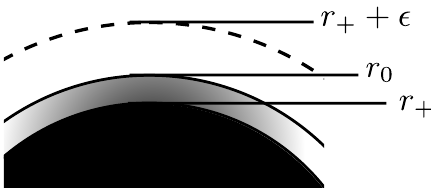
Figure 1. The boundary condition is imposed at a radius r + + (cid:15) such that physical observables do not depend on the precise value of (cid:15) . This is a cuto(cid:11) independent way to describe new physics in the region r + < r 0 < r + + (cid:15) (gray) where 0 < (cid:15) = r (cid:0) r + (cid:28) r s